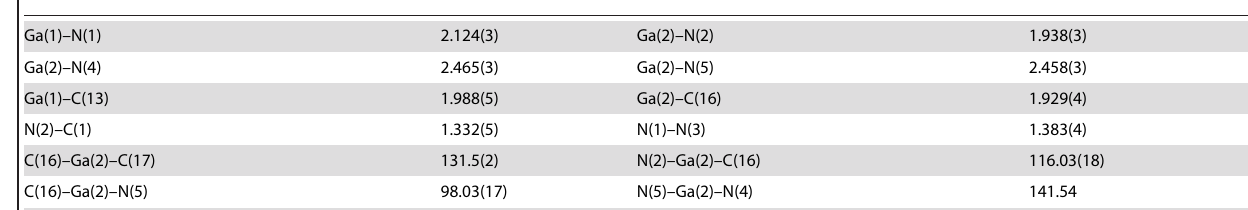
Table 3. Selected bond lengths (A˚) and angles (deg) for 2 .